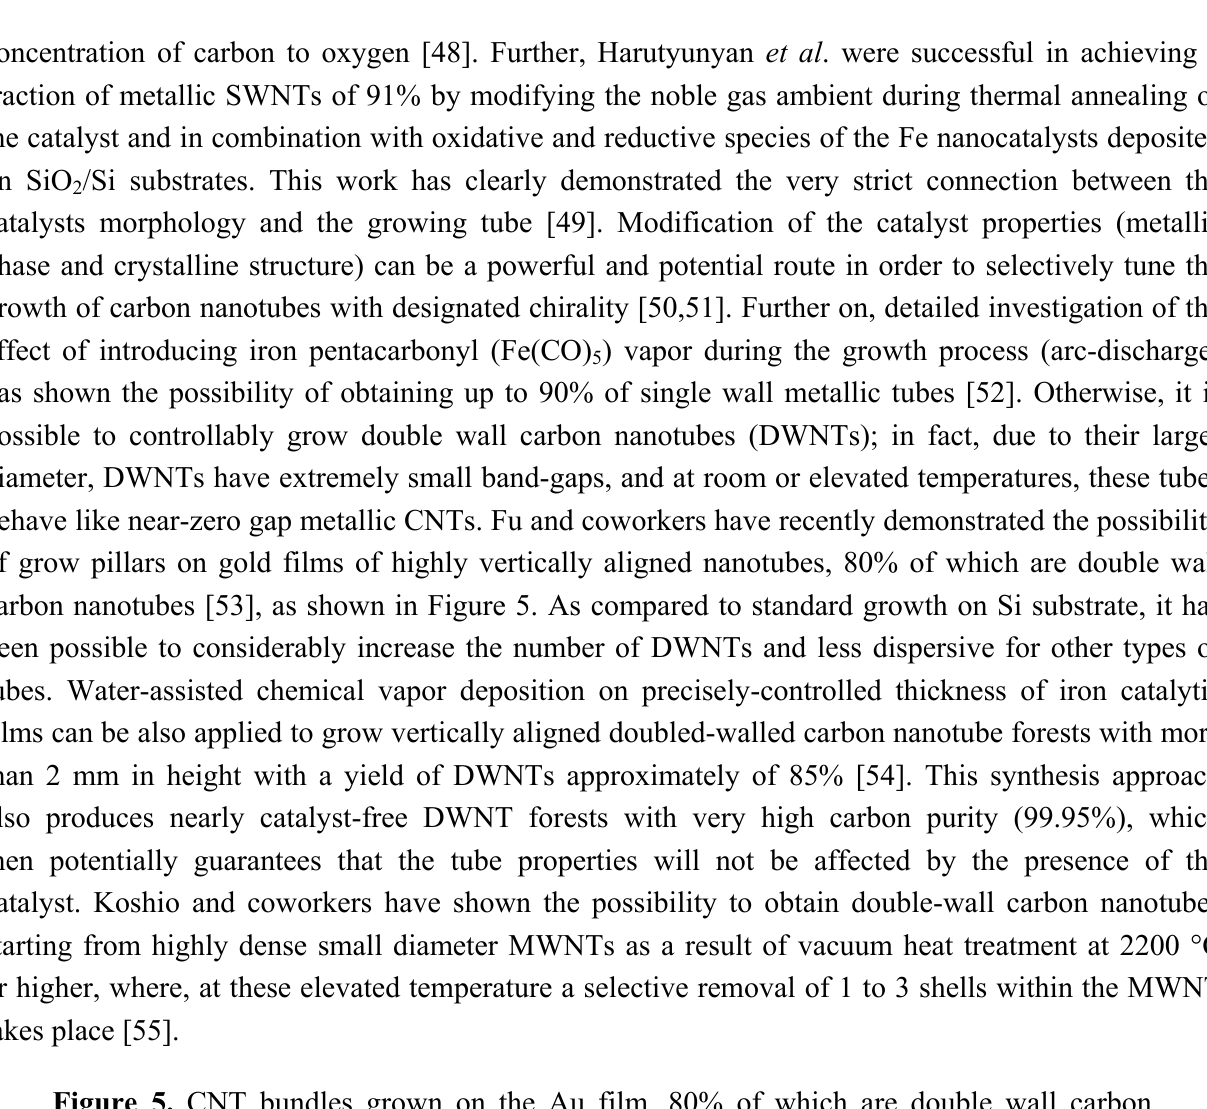
Figure 5. CNT bundles grown on the Au film, 80% of which are double wall carbon nanotubes (DWNTs). Top and side view show the large degree of vertical alignment of the tubes within the array